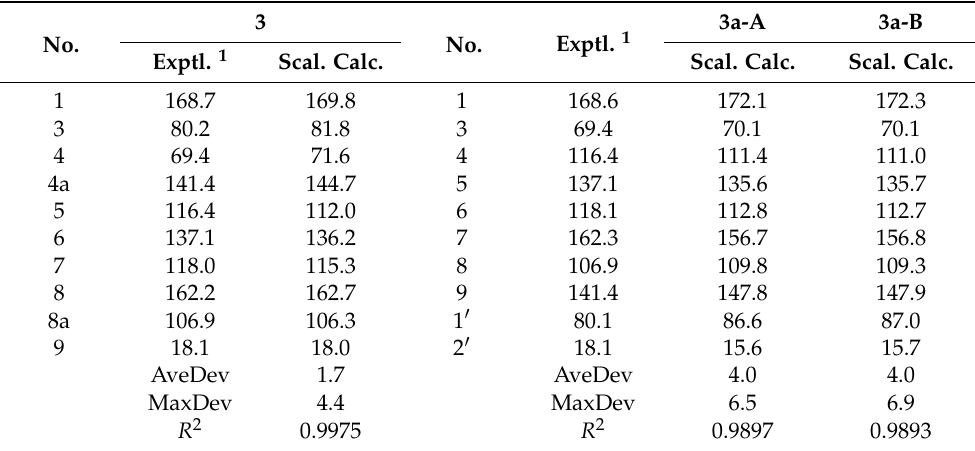
Table 2. Experimental and calculated 13 C NMR chemical shifts of 3 and 3a .